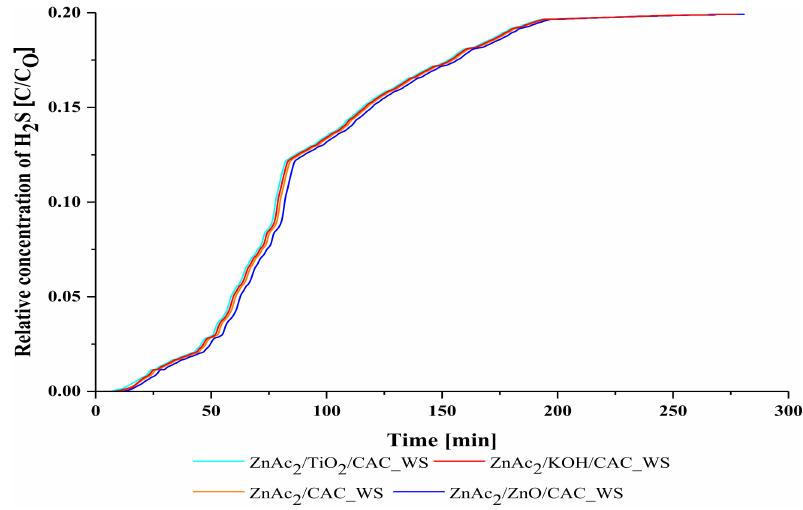
Figure 3. Relative concentration of H 2 S profile for CS/CAC_WS adsorbents.